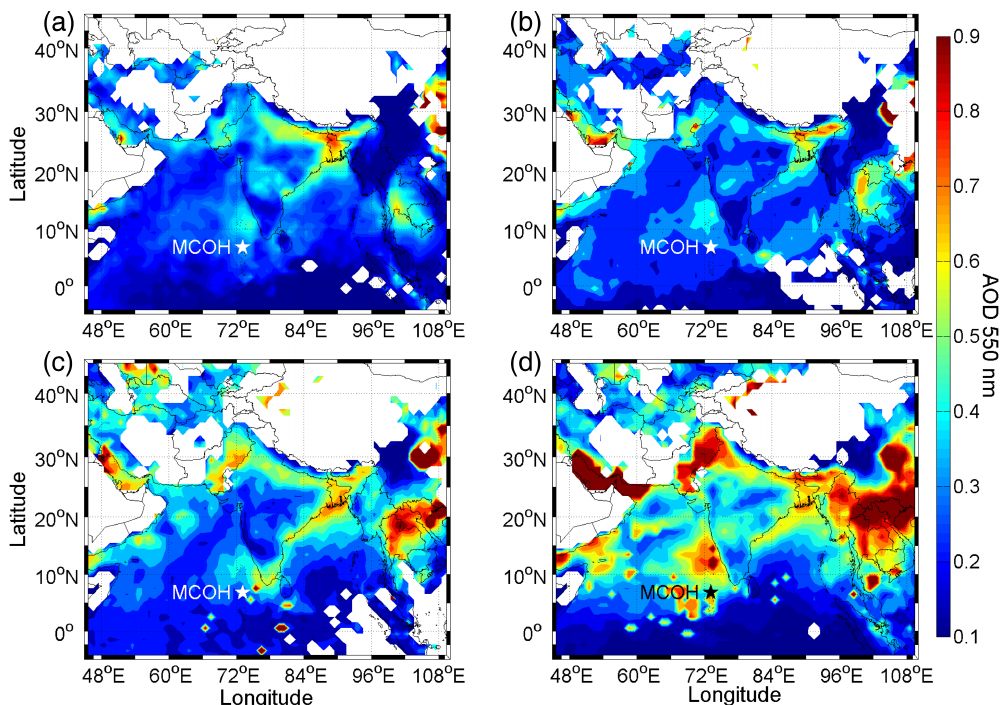
Figure 4. Mean AOD at 550nm derived from measurements by the MODIS instrument onboard the Terra satellite. (a) 1 until 14 Febru- ary 2012, (b) 15 until 29 February 2012, (c) 1 until 15 March 2012. (d) 16 until 31 March